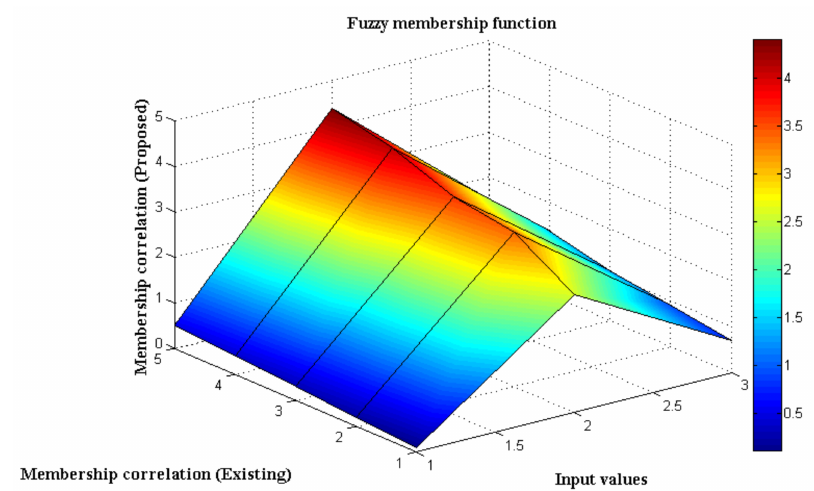
Figure 6. Rapport membership of fuzzy interference system.